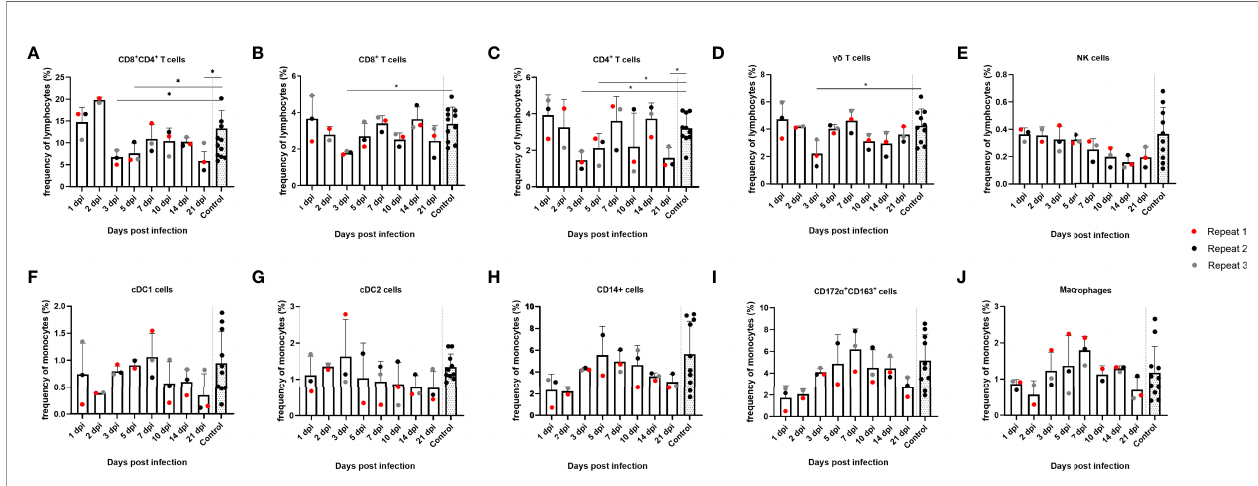
FIGURE 2 | Evolution of lymphocyte and monocyte frequencies in porcine tonsils upon JEV infection. Tonsil single-cell suspensions from 9-week-old intradermally inoculated pigs with JEV were analyzed by fl ow cytometry. Mean frequencies of (A) CD4 + CD8 + double-positive T cells, (B) CD8 + T cells, (C) CD4 + T cells, (D) gd T cells, (E) NK cells, (F) cDC1 cells, (G) cDC2 cells, (H) CD14 +, (I) CD172a + CD163 + , and (J) macrophages are displayed as bars. Three animals were analyzed per time point, and each dot represents one animal and expressed as the frequency of all lymphocytes for lymphocyte subsets or as the frequency of all monocytes for monocytic cell subsets. *Statistically signi fi cant different frequency compared to control